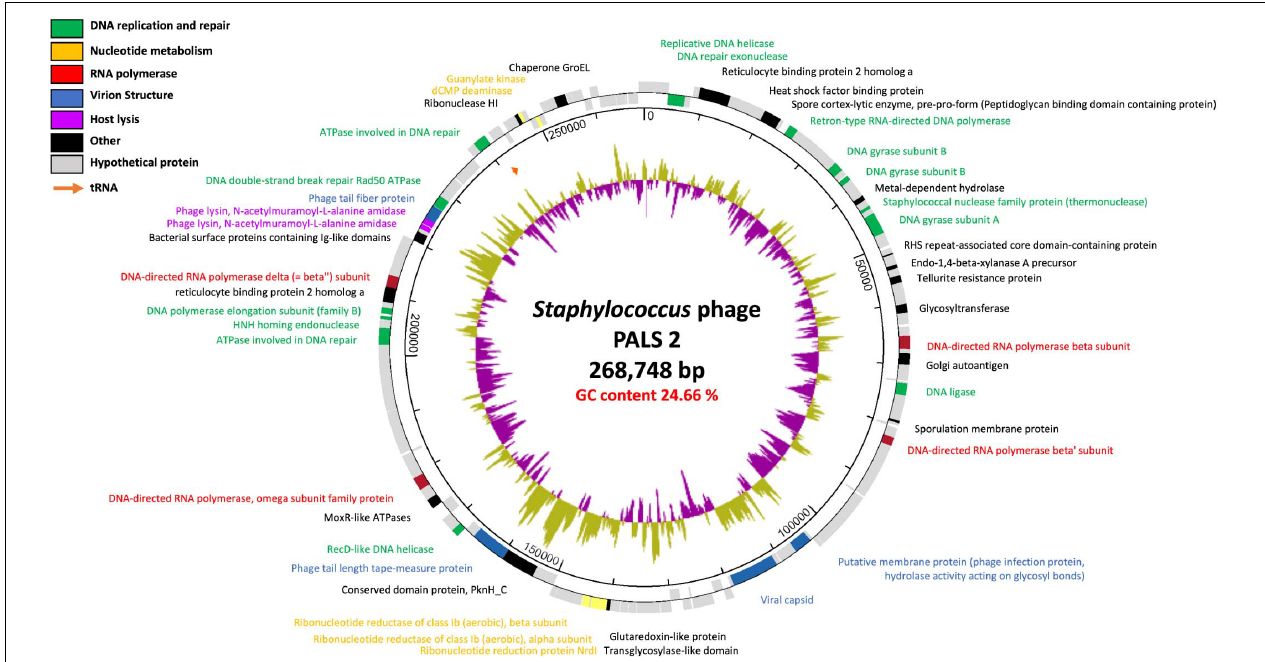
FIGURE 5 | Genome map of phage PALS2. Predicted ORFs are arranged on the PALS2 genome. Functional groups are categorized into colors as shown in the legend. The inner track represents the GC content plot (500-base window) of the phage.